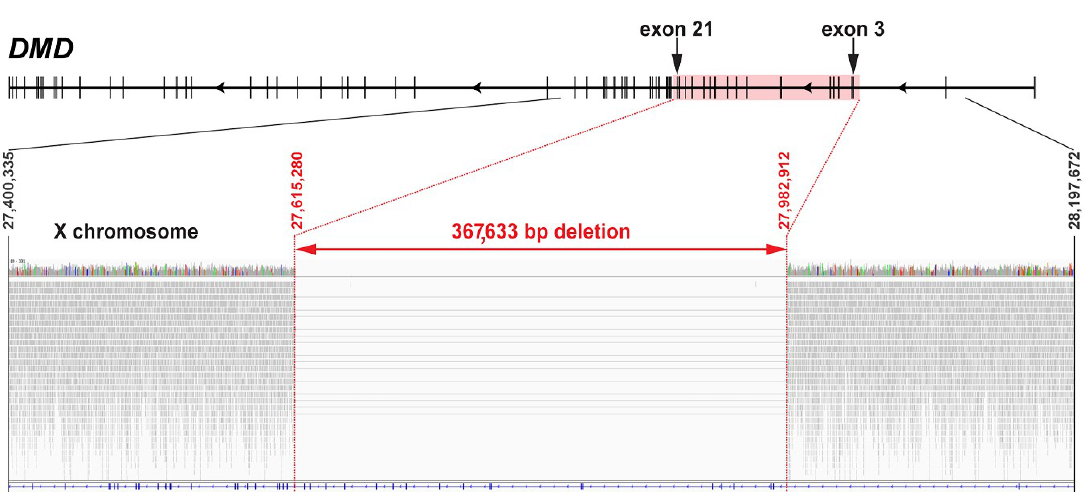
Figure 5. Large hemizygous partial deletion (CFAX g.[27,615,280_27,982,912del]) of the canine DMD gene in the Duchenne muscular dystrophy (DMD)-affected dog. The deletion spans exons 3–21 (highlighted by red box) and part of the flanking introns. The lower part shows an integrative genomics viewer screenshot of the region of interest from the whole-genome sequence data. Note the absence of mapped reads (shown in grey) within the region of 19 coding exons (red arrow). The light grey lines indicate read pairs, mapping across the breakpoints.